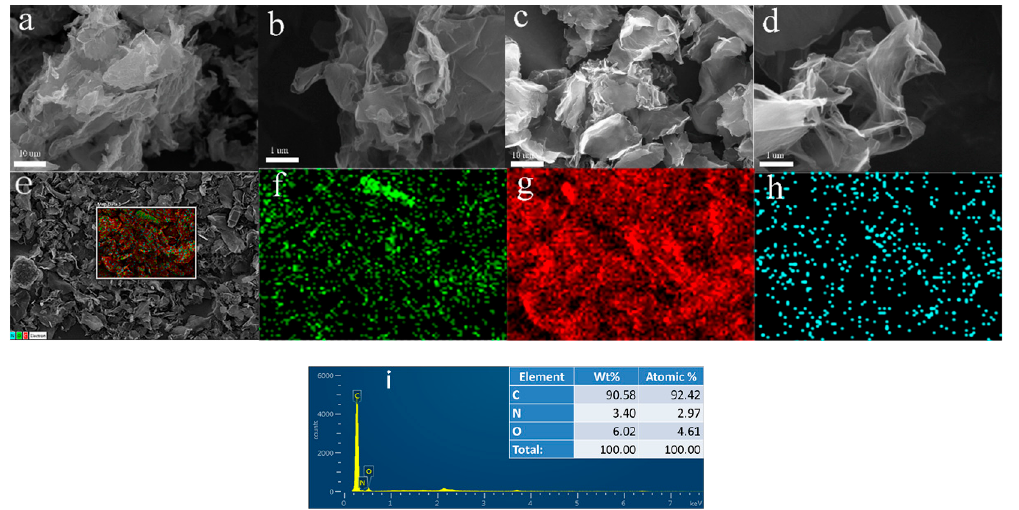
Figure 6. SEM images of RGO at 5000× ( a ) and 50,000× magnification ( b ); SEM images of NG at 5000× magnification ( c ) and 50,000× magnification ( d ); ( e ) EDS images of NG; distribution diagram of